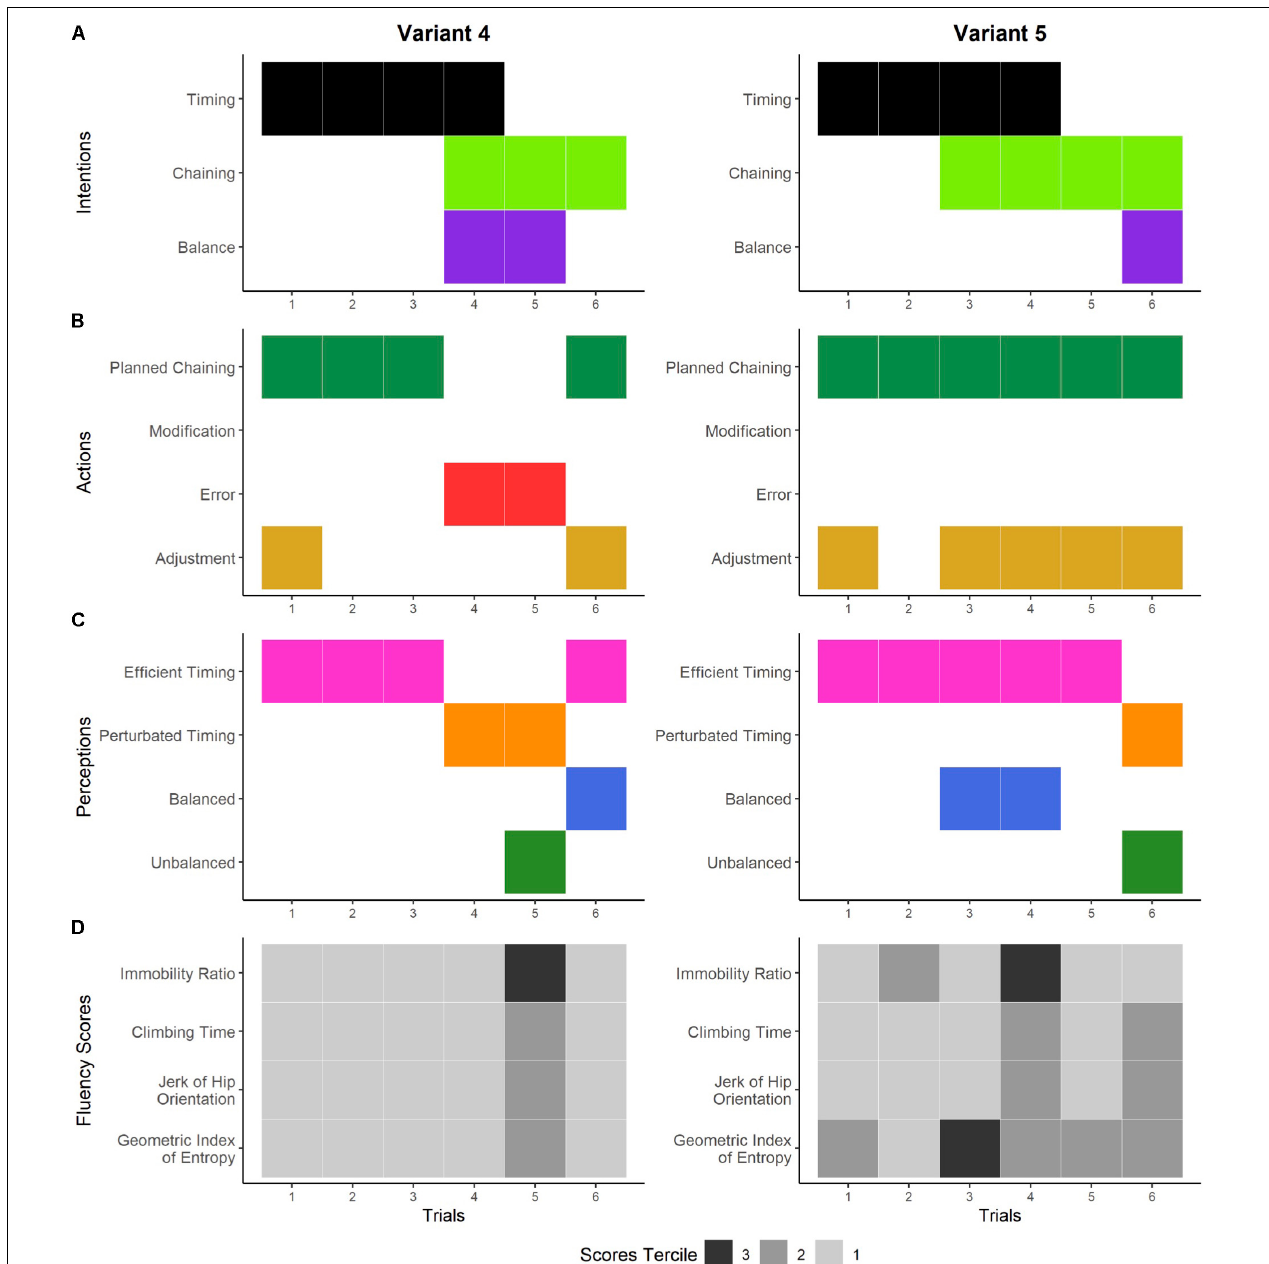
FIGURE 6 | Dynamics of the climber’s experience and performances on variants 4 and 5. Panels A–C show the temporal organization of the general dimensions of the different components of experience detected during the interviews. Panel A shows the general dimensions of the climber’s intentions: improving the timing of the climb (black), ensuring the correct execution of movement chaining (light green), and seeking and maintaining balance while climbing (purple). The climber’s actions are shown in panel B: carrying out the planned chaining (dark green), deliberately modifying the planned movements while climbing (light blue), making errors while climbing (red), and adjusting the foot chaining while climbing (gold). Panel C shows the general dimensions of the climber’s perceptions: sensation of efficient timing (pink), sensation of perturbed timing (orange), sensation of being balanced (dark blue), and sensation of being unbalanced (green). Panel D shows the score terciles for each fluency indicator. The climbing performance is expressed in the terciles: tercile 3 (in black) refers to his poorest performances, tercile 2 (in dark gray) refers to his intermediate performances, and tercile 1 (in light gray) refers to his best performances.